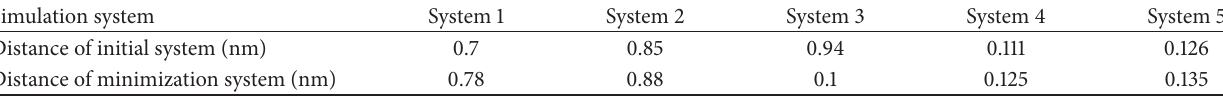
Table 1: Distances of two NZVI particles in initial system and minimization system of systems